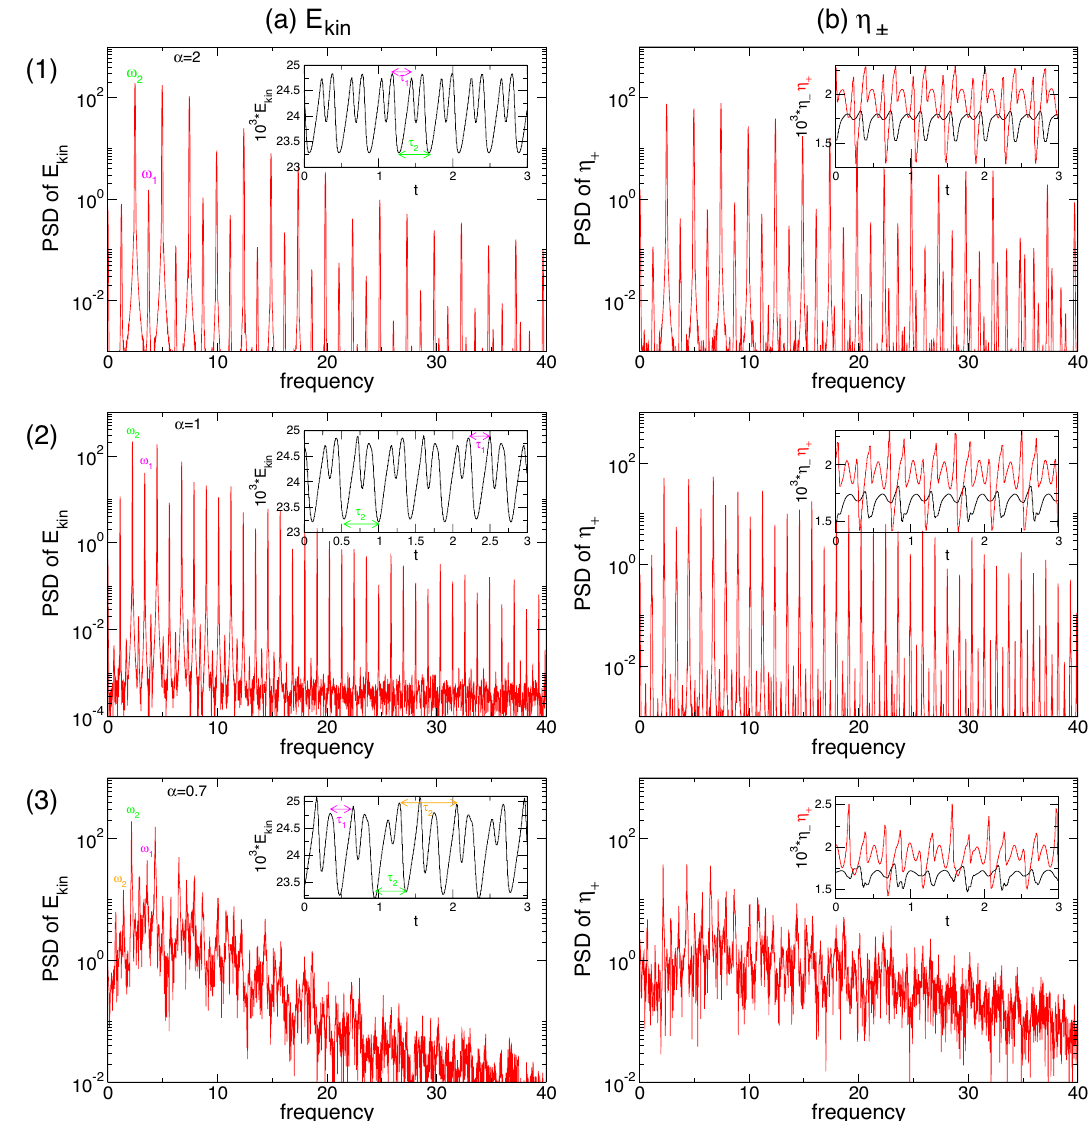
Figure 12. Time series and power spectral densities (PSDs) of pVs for different α . PSDs of ( a ) E kin and ( b ) η 2 with period time τ P 1 with 0.405 and corresponding frequency ω P 2.47 ; (2) α for pVs: (1) α = = ≈ ≈ + 0.7 with period time τ P 0.896 and corresponding frequency ω P 1.116 ; (3) α 1.395 and period time τ P = ≈ ≈ ≈ 0.717 . Insets show time series of E kin , η corresponding frequency ω P [red], and η [black], ≈ + −